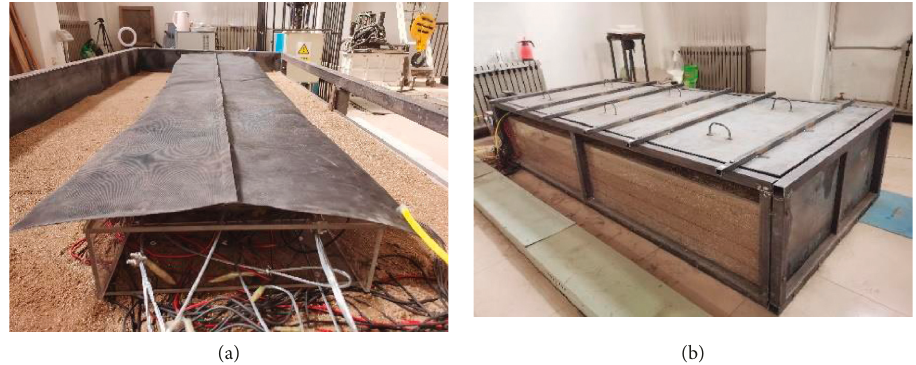
Figure 9: Self-balancing loading device: (a) airbag and (b) the top cover of the model box is closed.